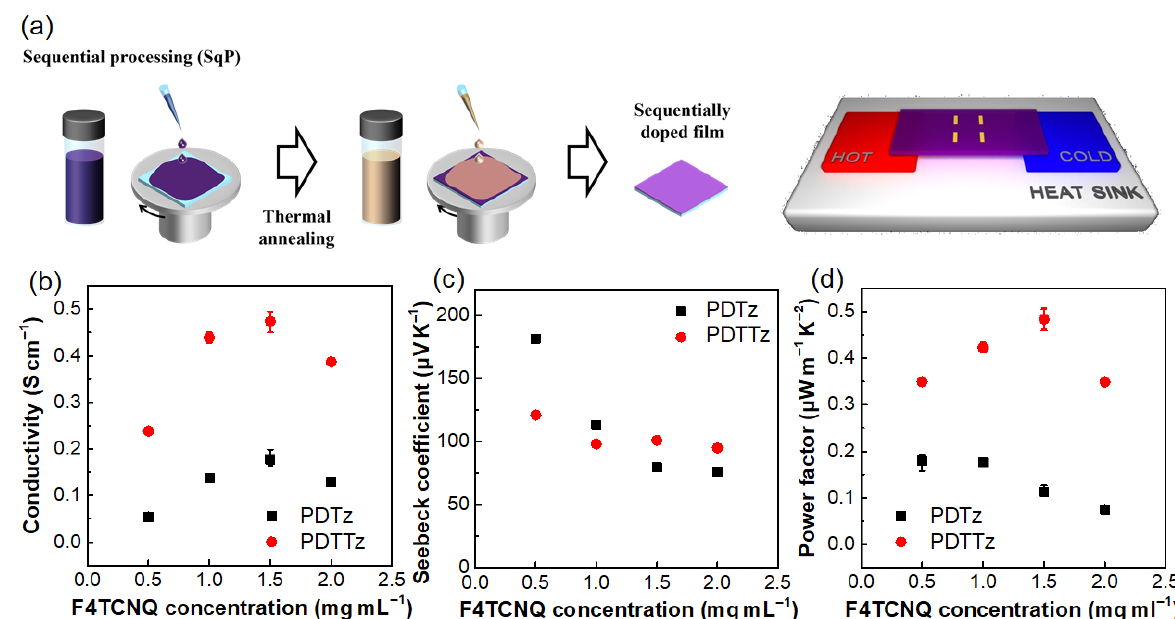
Figure 2. ( a ) Layer structure of OTE devices. ( b ) Seebeck coefficient, ( c ) conductivity, and ( d ) power factor of PDTz and PDTTz devices.